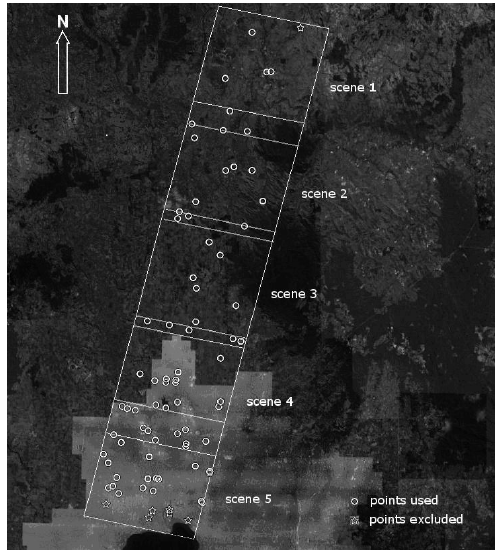
Figure 4. THEOS 5-image strip and distribution of GCPs in Melbourne test field.